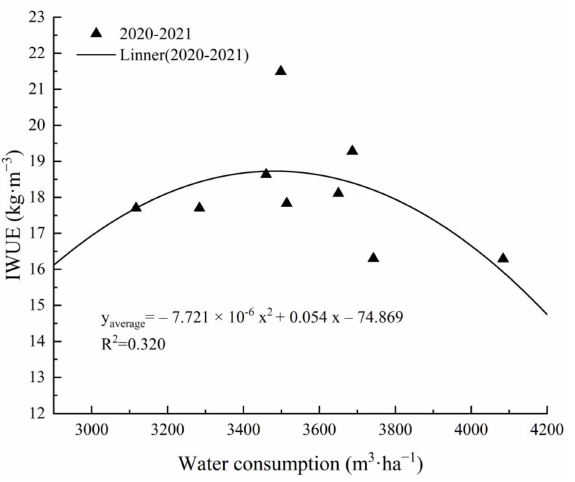
Figure 7. Relationship between water consumption and IWUE of